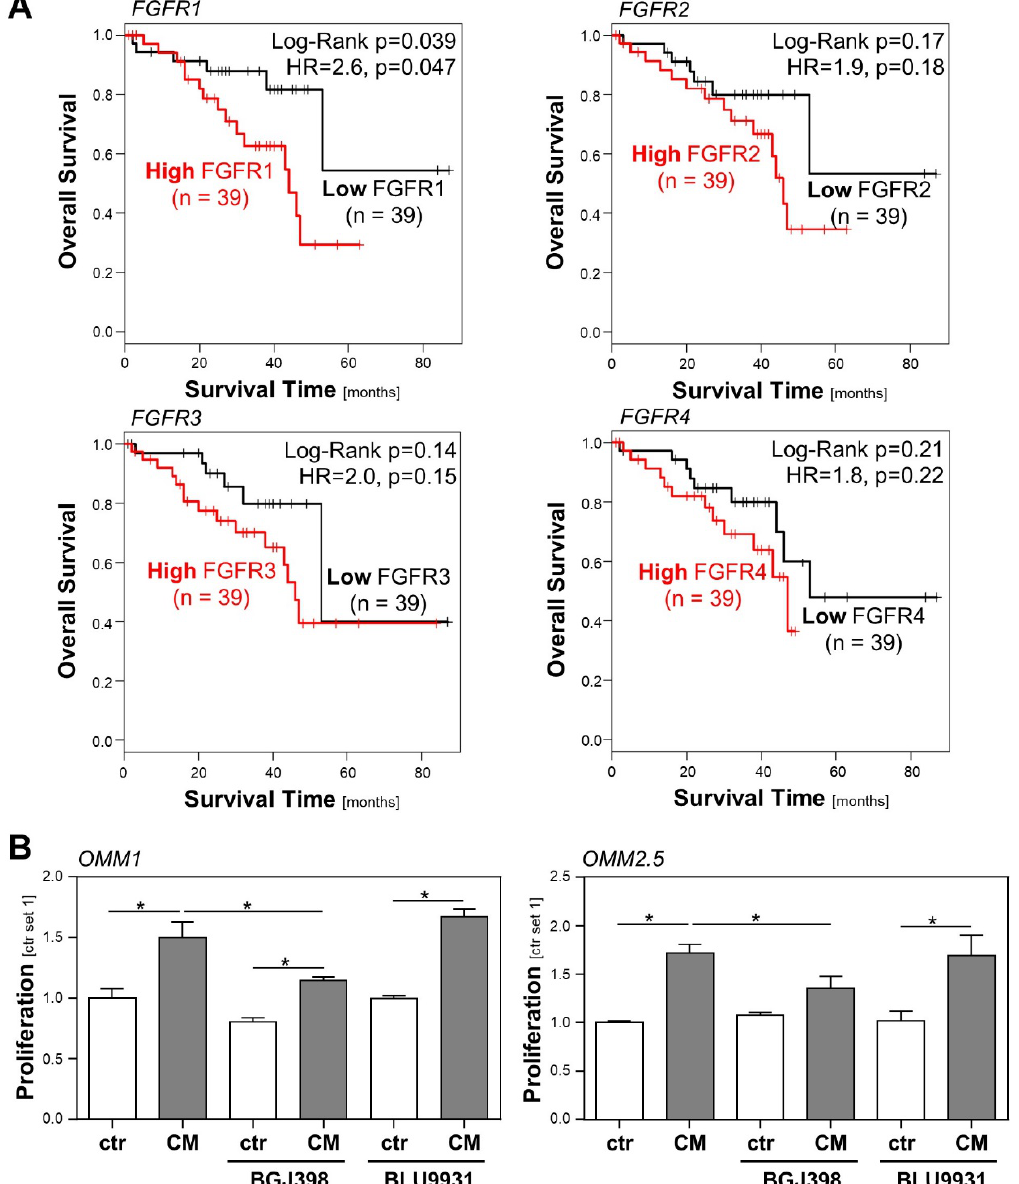
Figure 2. Role of the FGF/FGFR system in the prognosis of uveal melanoma (UM) patients, and in the interaction between hepatic stellate cells (HSCs) and UM cells. ( A ) Correlation between high/low FGFR1-4 expression and overall survival of UM patients applying a TCGA dataset of 78 UM patients and GEPIA database. ( B ) Effects of BGJ398 (FGFR1-3 inhibitor; 200 nM) and BLU9931 (FGFR4 inhibitor; 100 nM) on HSC-CM-induced proliferation of OMM1 cells (left panel) and OMM2.5 cells (right panel). Proliferation was assessed 48h after the stimulation of cells (*: p < 0.05).